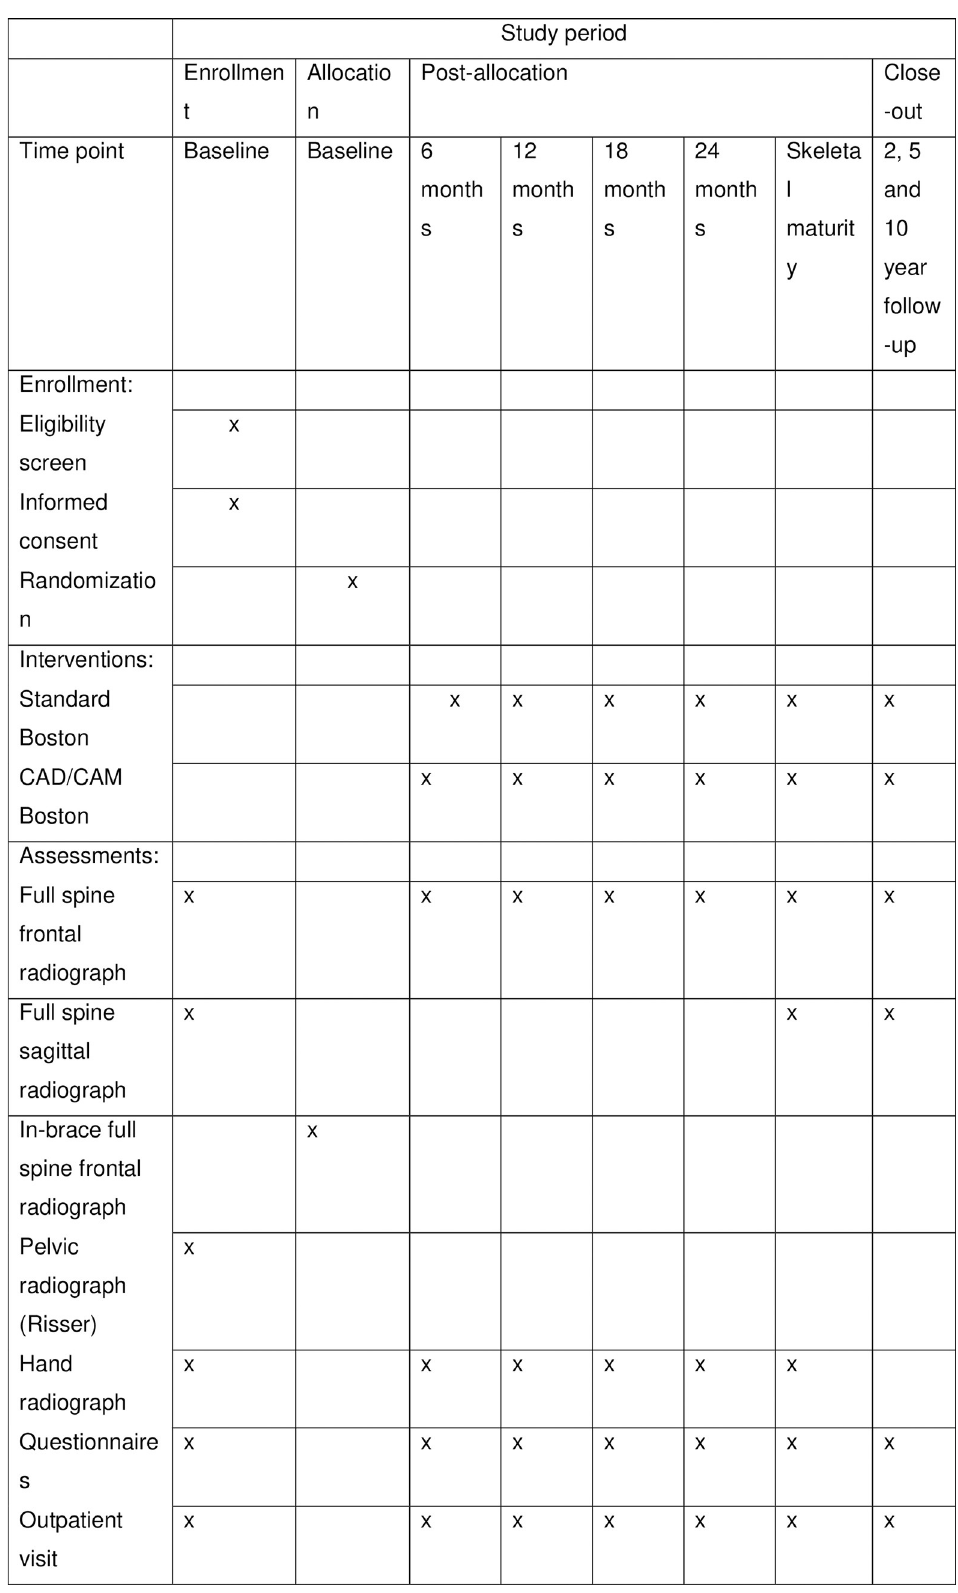
Fig 2. SPIRIT 2013 checklist: Recommended items to address in a clinical trial protocol and related